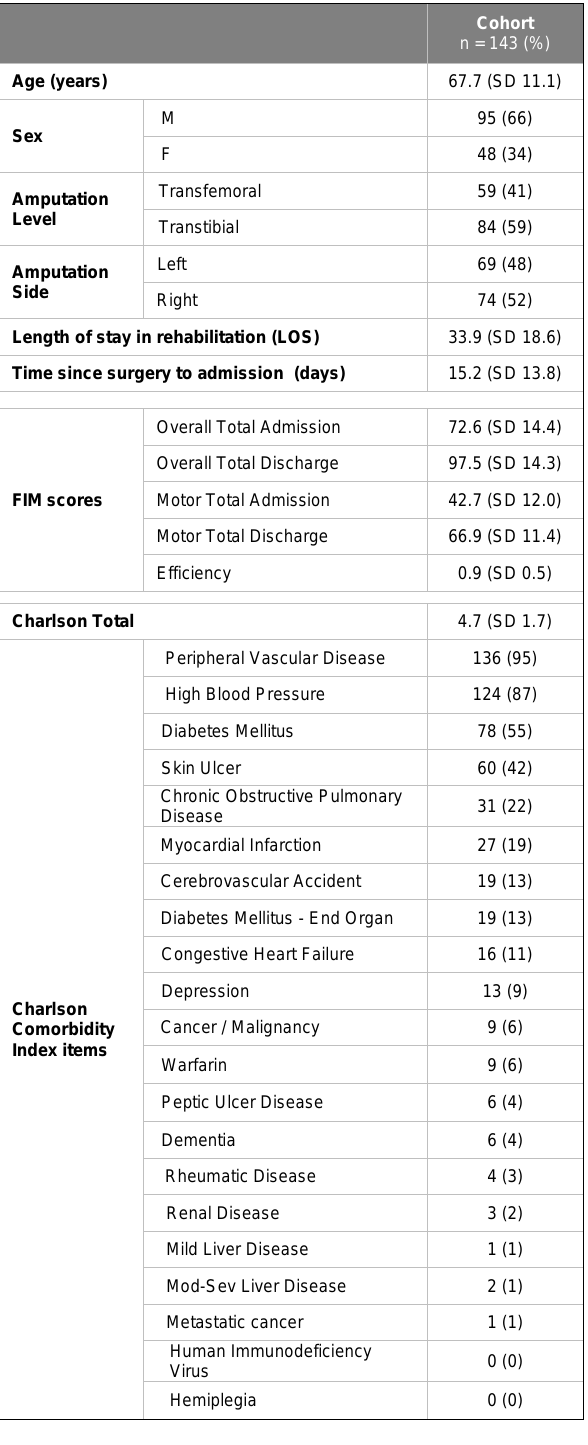
Table 1: Cohort characteristics and Charlson Comorbidity